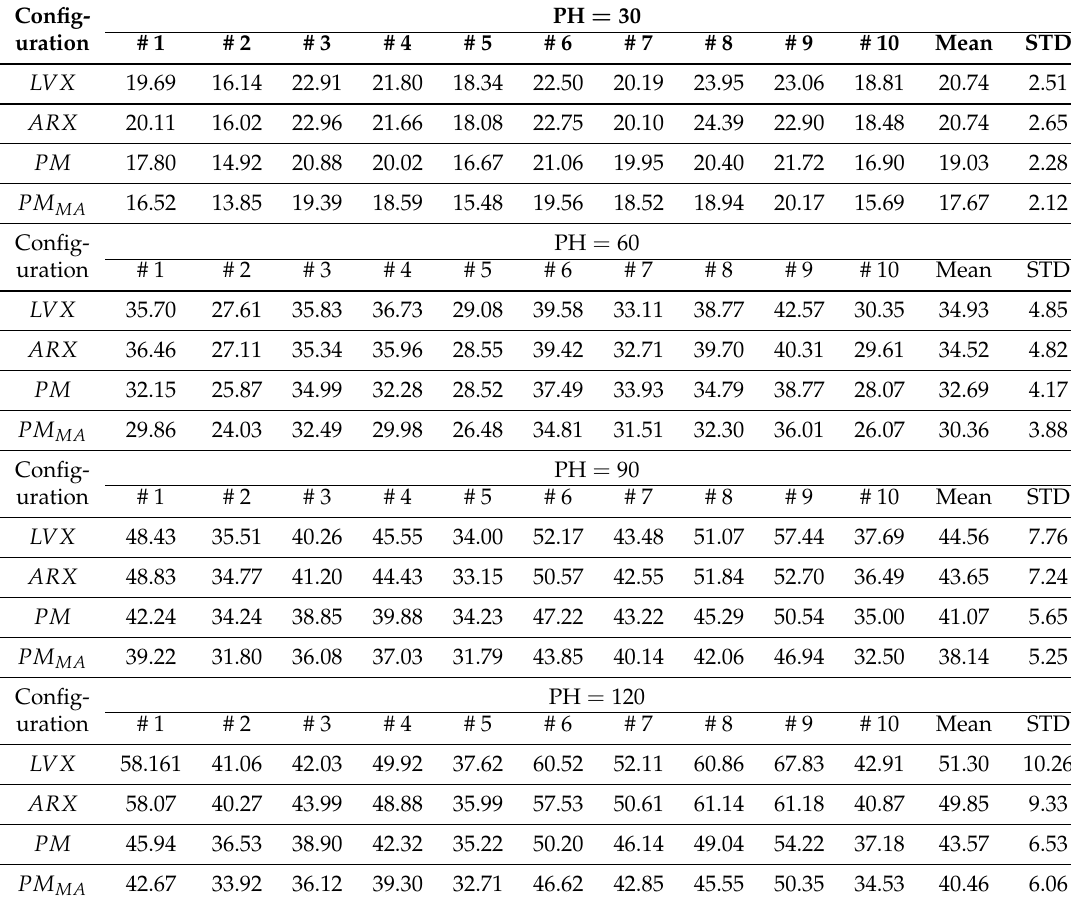
Table A4. Individual RMSE results (in mg/dL) corresponding to the 10-adult clinical cohort for the studied algorithms and different PH in